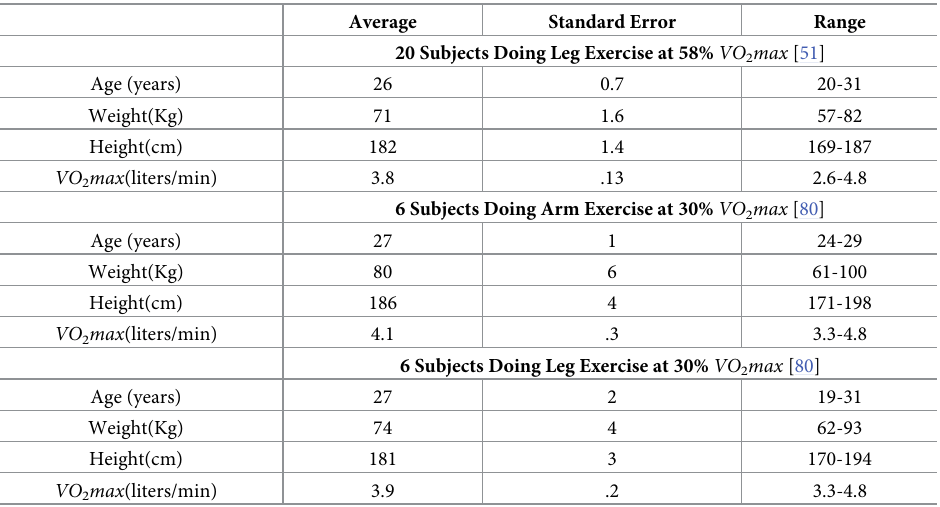
Table 6. Characteristics of subjects reported in [51] and [80].